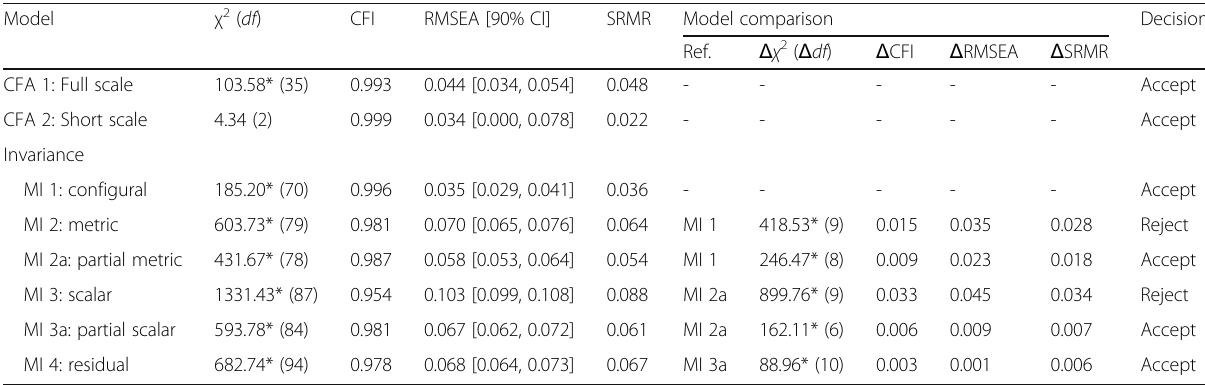
Table 2 Confirmatory factor analysis (CFA) and measurement invariance (MI) model fit Model χ 2 ( df ) CFI RMSEA [90% CI] SRMR Model